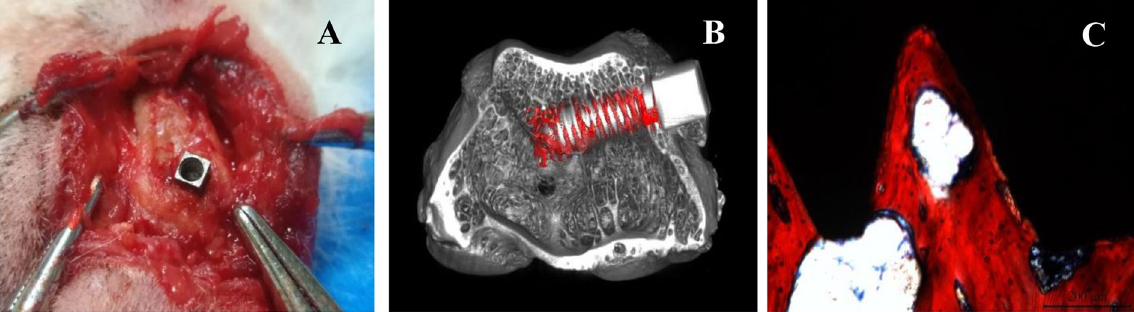
Figure 4. Bone formation for osseointegration after 3 months. ( A ) Healing of cortical bone. ( B ) Micro-CT images show good osseointegration in the area surrounding the implant. ( C ) VG staining shows favourable implant-bone